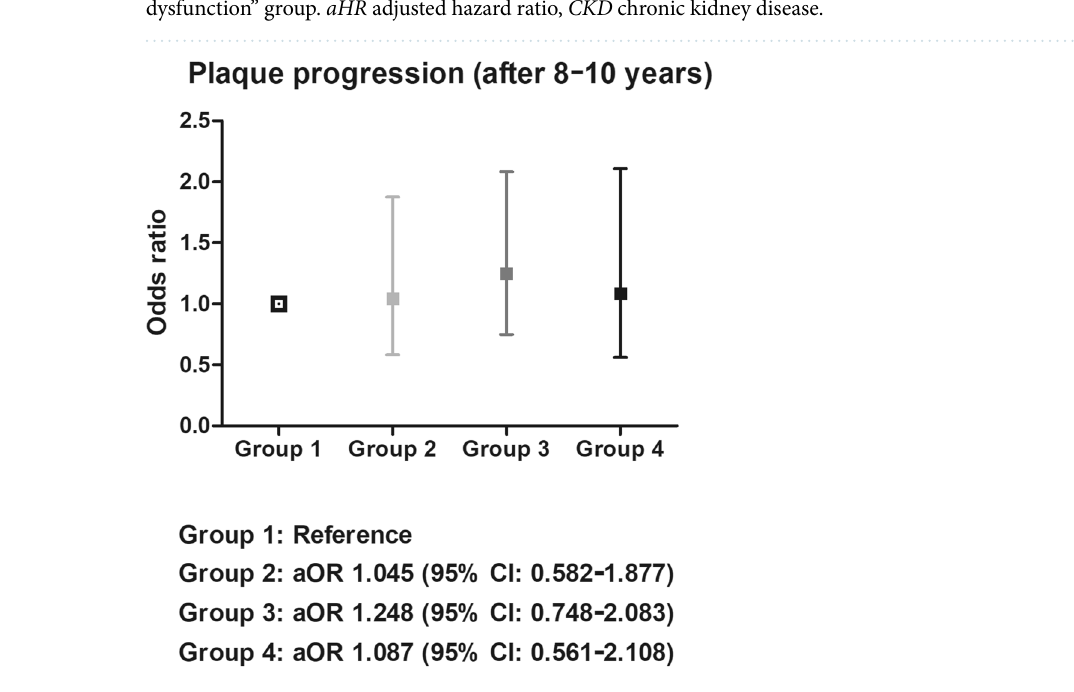
Figure 2. Risk of developing diabetic complications by group. Kaplan–Meier curve and hazard ratios of ( a ) retinopathy and ( b ) chronic kidney disease. The results were adjusted for age, sex, diabetes duration, systolic blood pressure, diastolic blood pressure, time of enrollment, BMI, HbA1c levels, LDL cholesterol levels, eGFR (not included in the analysis depicted by [ b ]), statin use, smoking status, alcohol consumption, and physical activity. Group 1. Reference (mild insulin resistance and beta-cell dysfunction) group. Group 2. “Severe beta-cell dysfunction” group. Group 3. “Severe insulin resistance” group. Group 4. “Severe insulin resistance and beta-cell dysfunction” group. aHR adjusted hazard ratio, CKD chronic kidney disease.